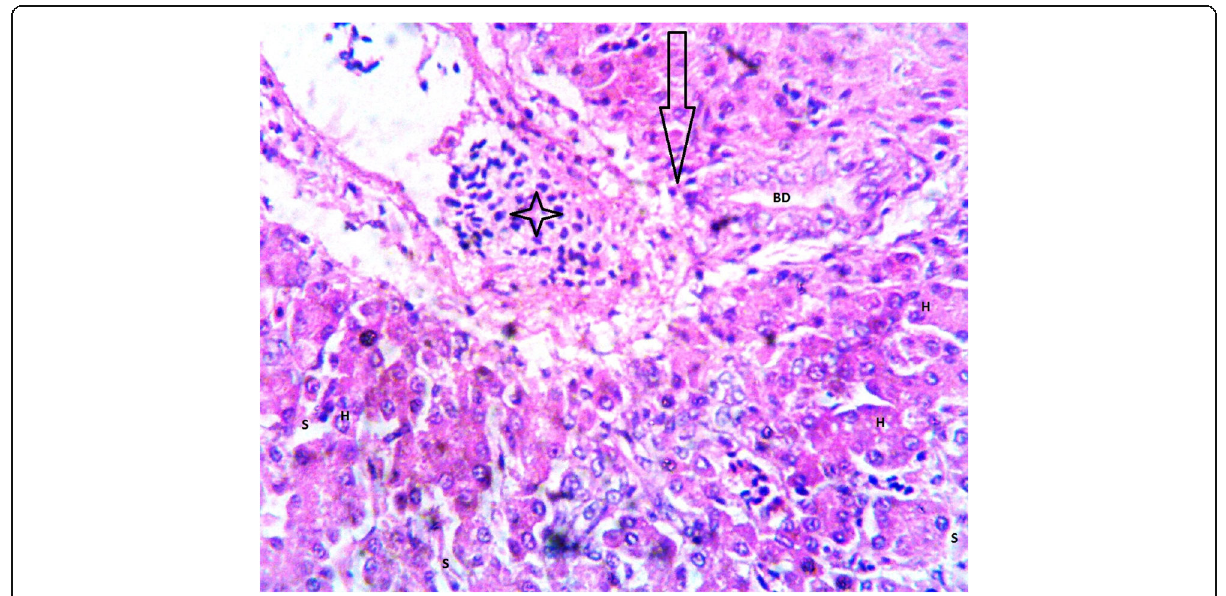
Fig. 1 Representative micrograph of liver section (× 400) of broiler chicks fed 0.0 % PCM supplemented diet. This section shows the hepatic tissues composed of hepatocytes (H) disposed of in the sheet and is separated by sinusoids (S) free of collections and inflammatory cells, the